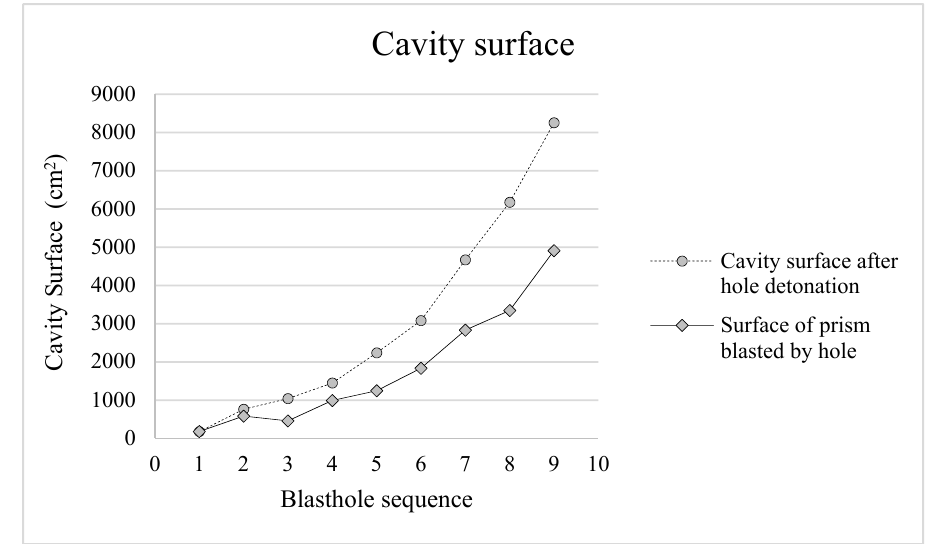
Figure 3. Evolution of the cross-section surface of the cavity generated by the evolution of the opening cut (dashed) and surface of each prism detached by the corresponding blasthole.